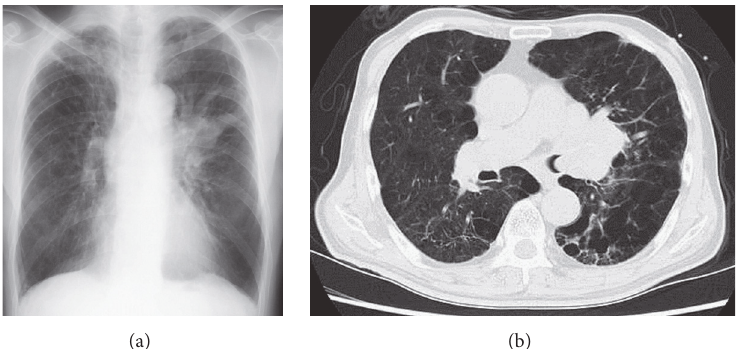
Figure 1: (a) Chest X-ray on admission revealed a mass in the left hilar region. (b) Chest computed tomography on admission showed a mass invading the left main bronchus.